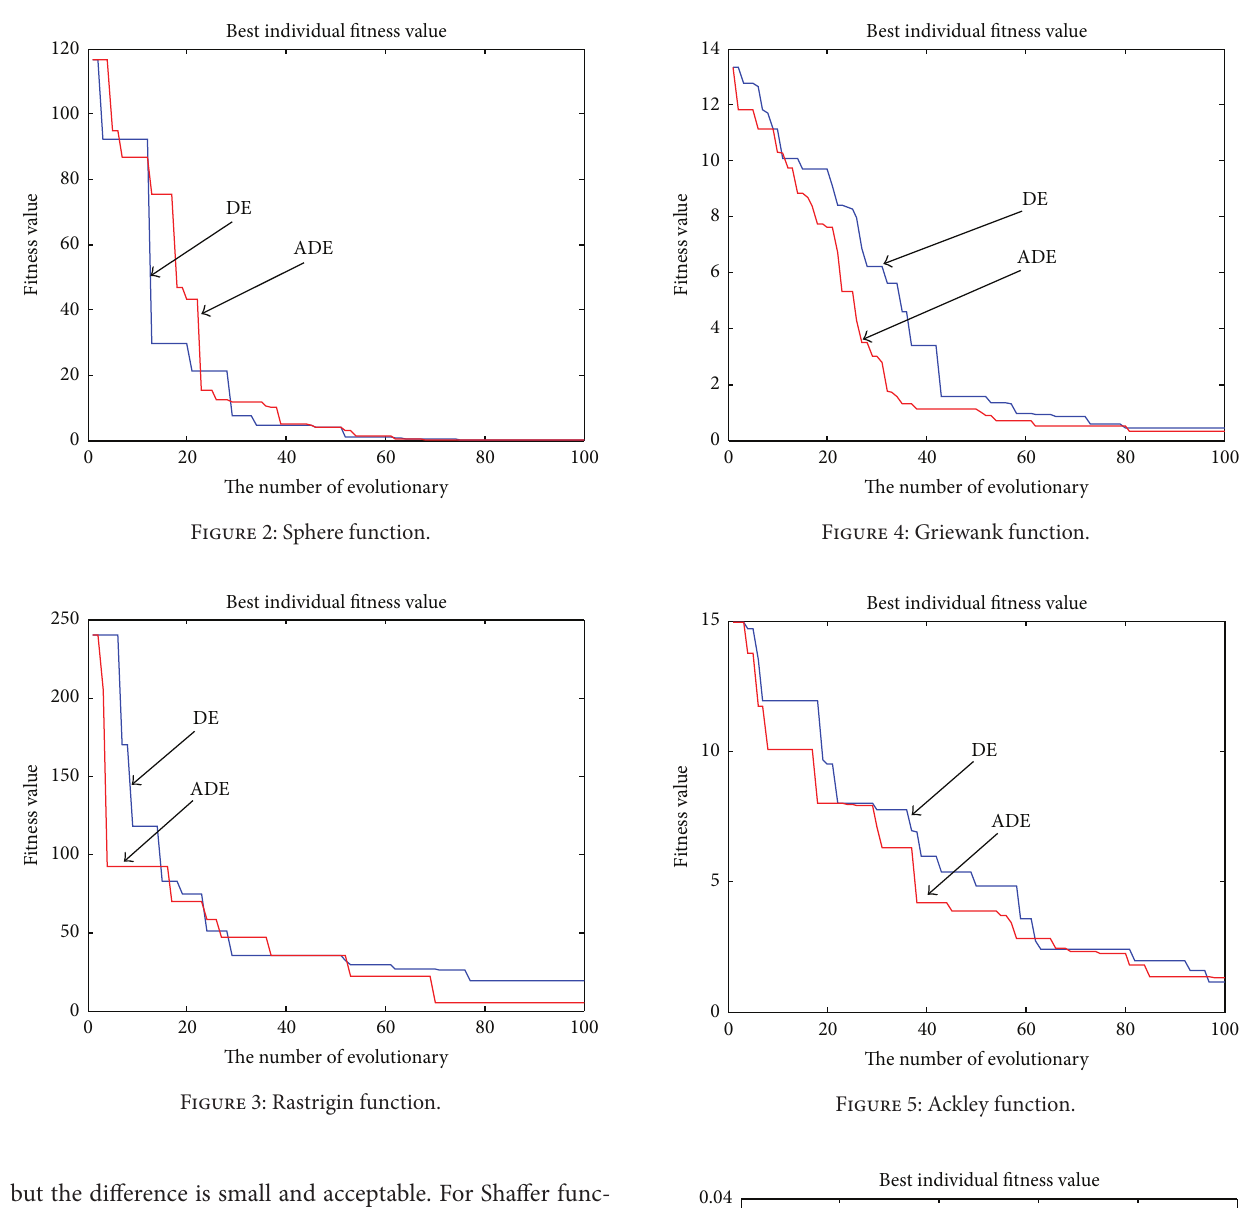
Figure 4: Griewank function.